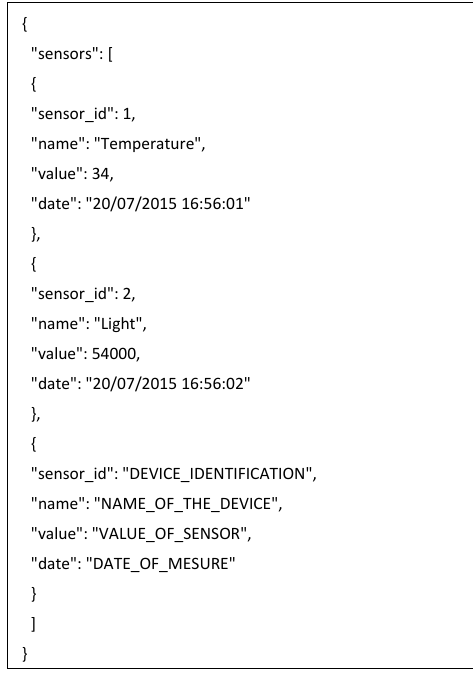
Figure 17. Message structure.